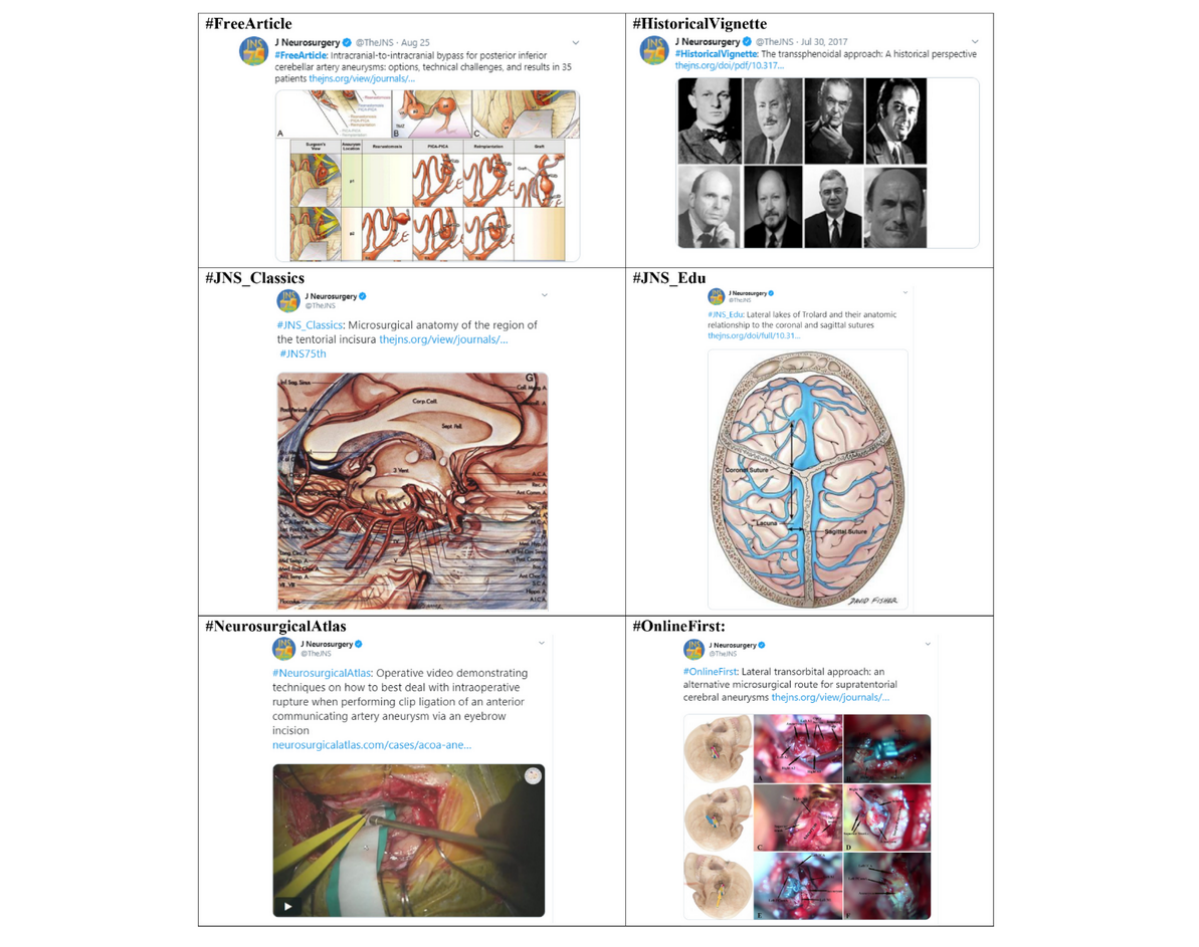
Figure 1. Examples of different types of Journal of Neurosurgery Publishing Group (JNSPG) Twitter